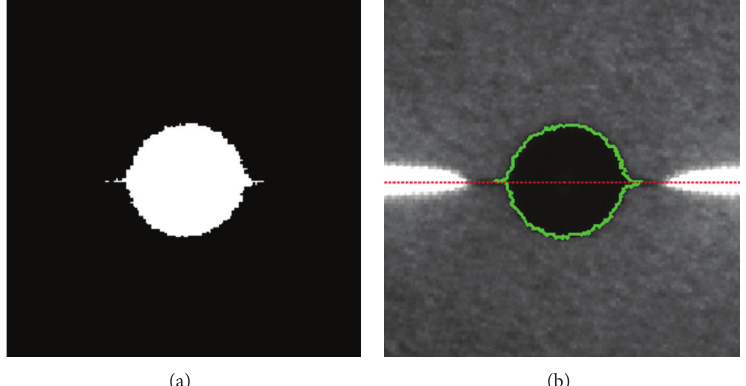
Figure 3: Images showing (a) the binary image with a thin fiber and (b) the droplet outline and fiber location.